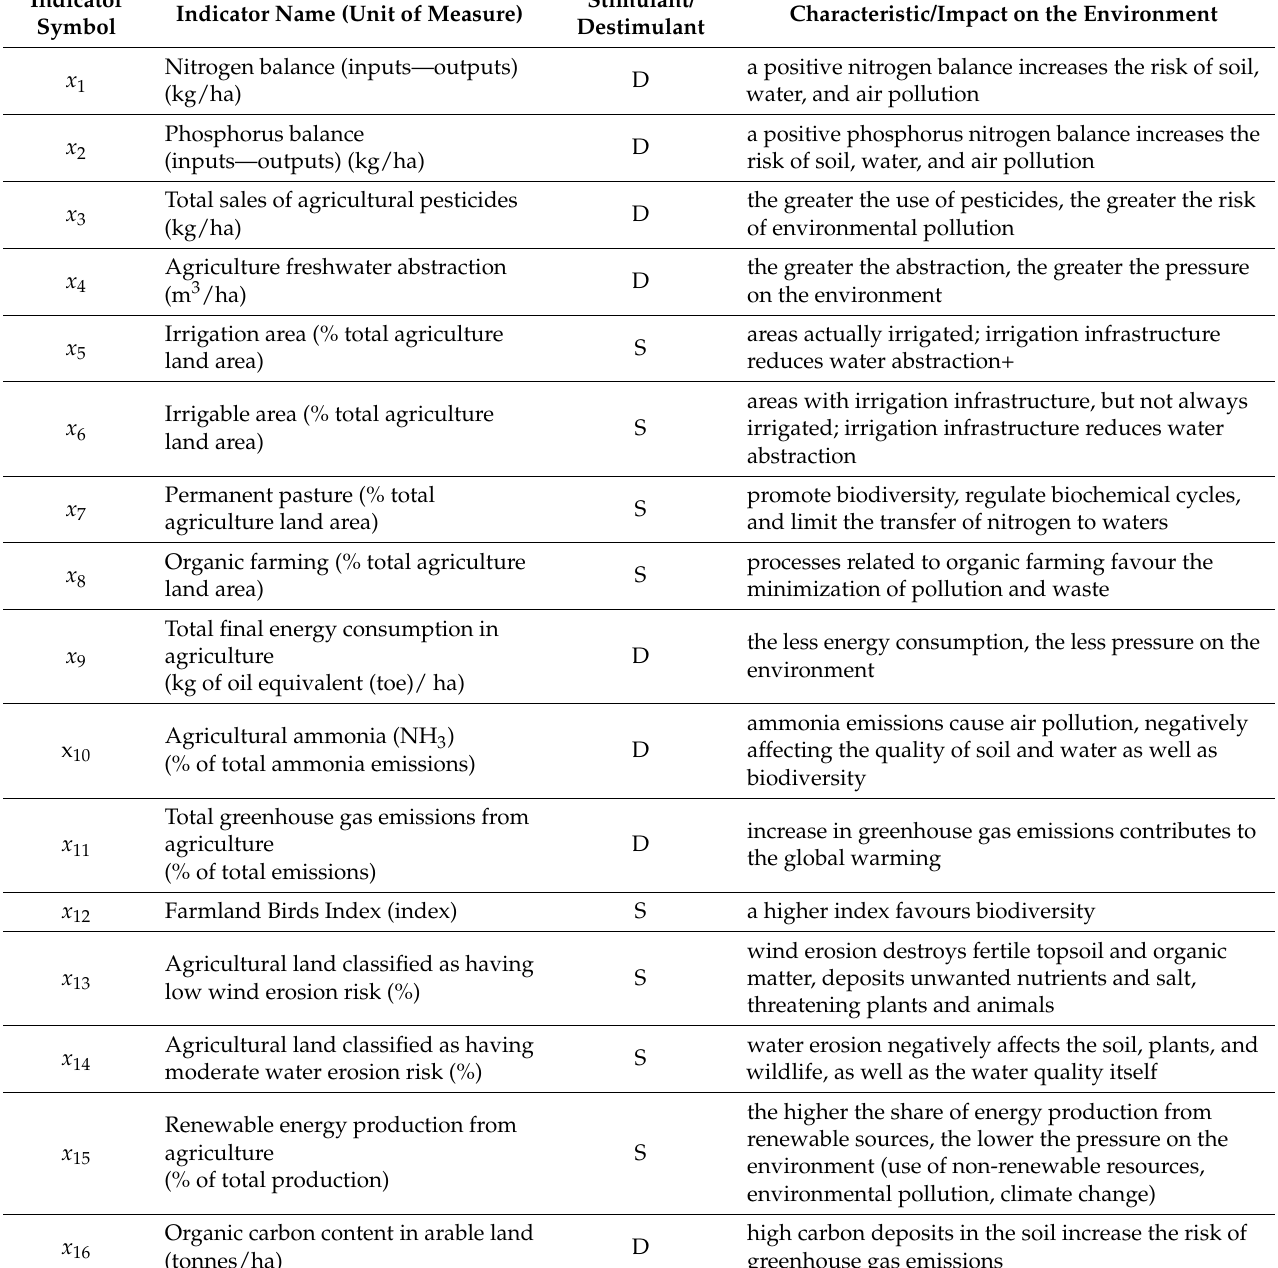
Table 1. Indicators selected for the